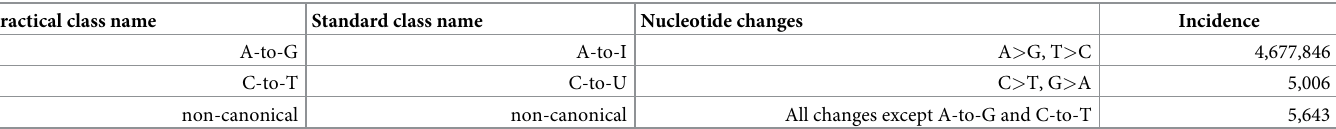
Table 2. RNA editing event classes.